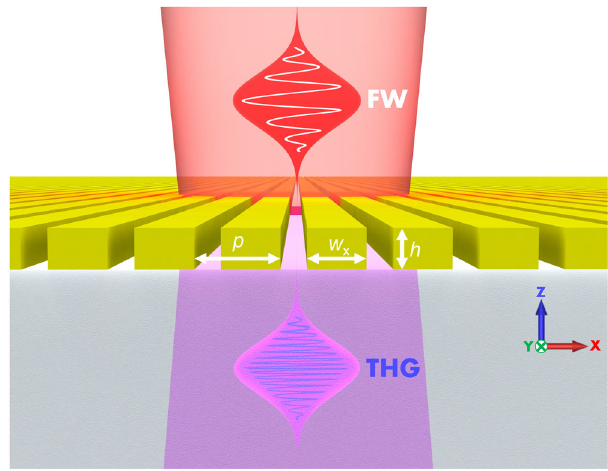
Fig. 1 Third harmonic generation in the ultra-violet spectral range of As 2 S 3 . An arsenic trisul fi de nanowire-based metasurface on a silica substrate, enabling the desired enhancement of third harmonic